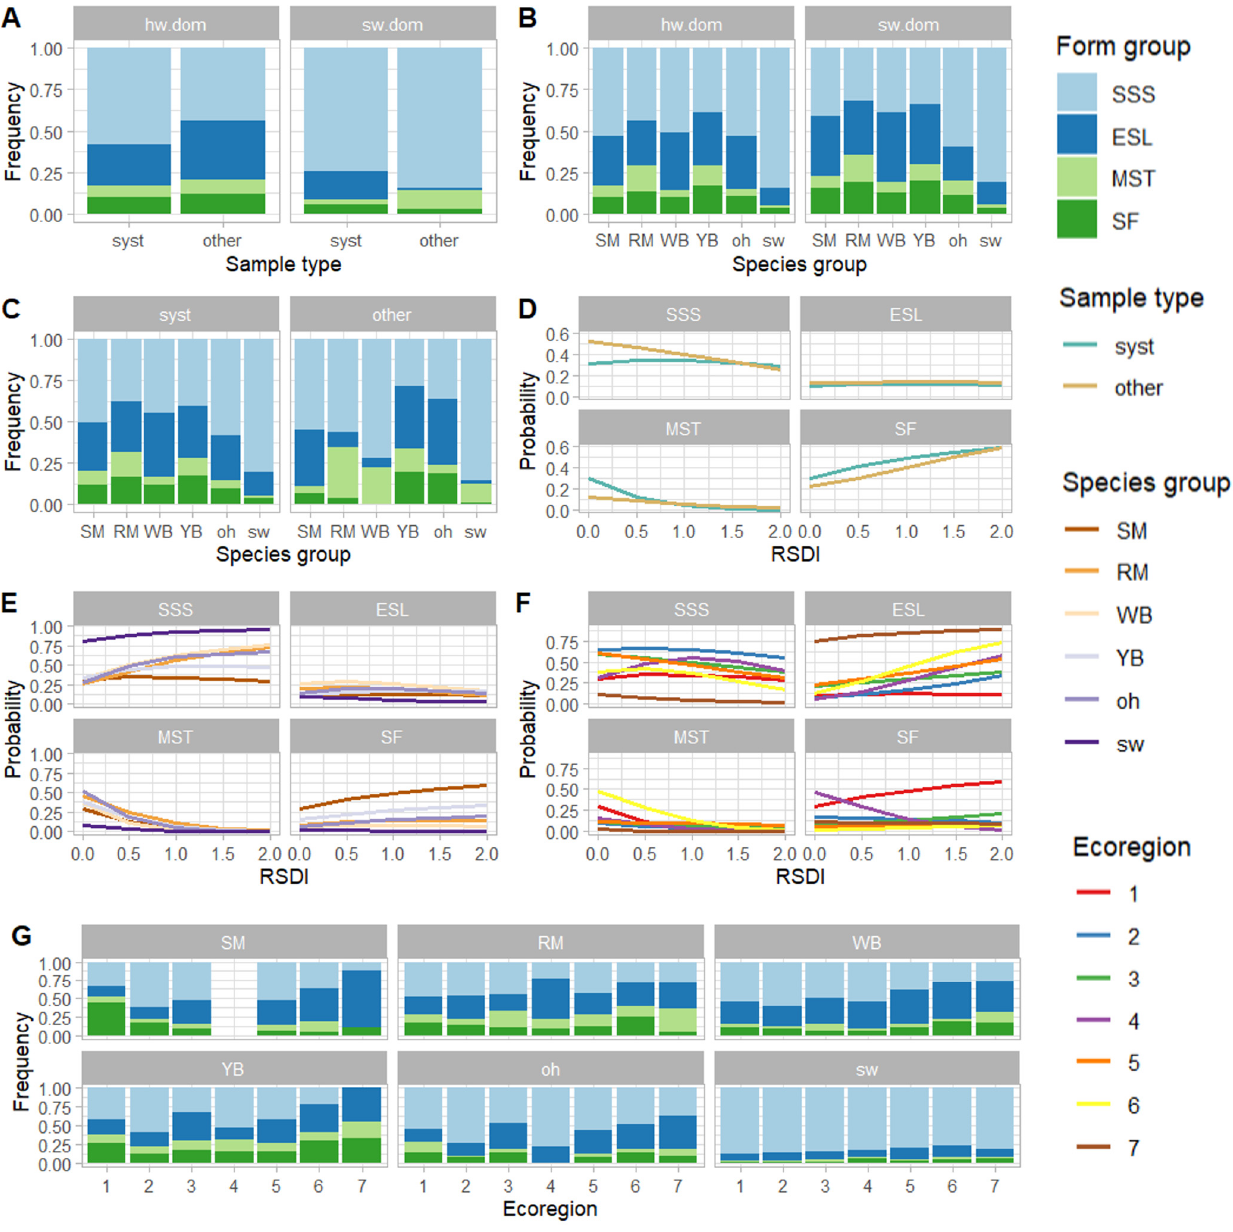
Figure 6. Form group of trees (N = 25,560) depending on plot dominance (hardwood dominated (“hw.dom”) or softwood dominated (“sw.dom”)) and sample type (systematic “syst” or other) ( A ), plot dominance and grouped species (SM: sugar maple; RM: red maple; WB: white birch; YB: yellow birch; oh: other hardwoods; sw: softwoods) ( B ), sample type and species group ( C ), sample type and stand density (RSDI) ( D ), RSDI and species group ( E ), RSDI and ecoregion ( F ), and ecoregion and grouped species ( G ). Form groups are single straight stem (SSS), extensive sweep or lean (ESL), multiple stems (MST) and significant fork (SF).